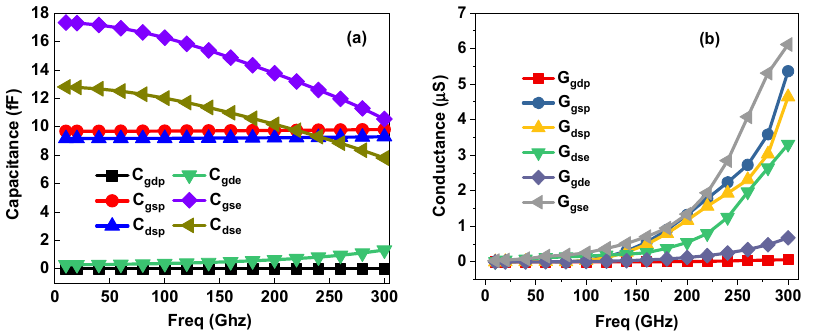
Figure 6. ( a ) Inter-electrode equivalent capacitances and ( b ) inter-electrode equivalent conductance of the GSG test layout.